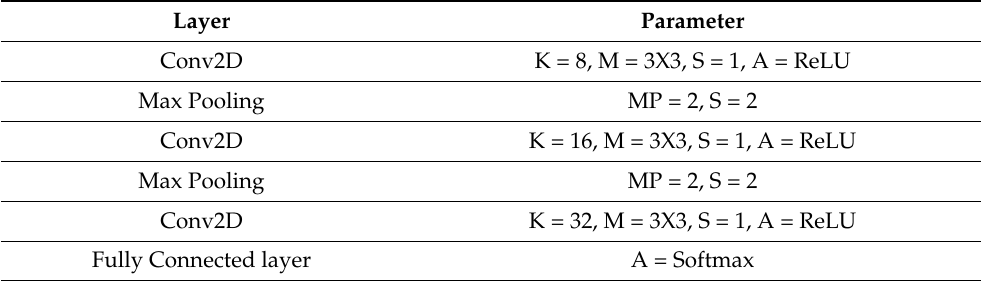
Figure 10. Structure of convolutional neural networks used in the experiment. Table 3. Proposed convolutional neural network structure (learning rate =